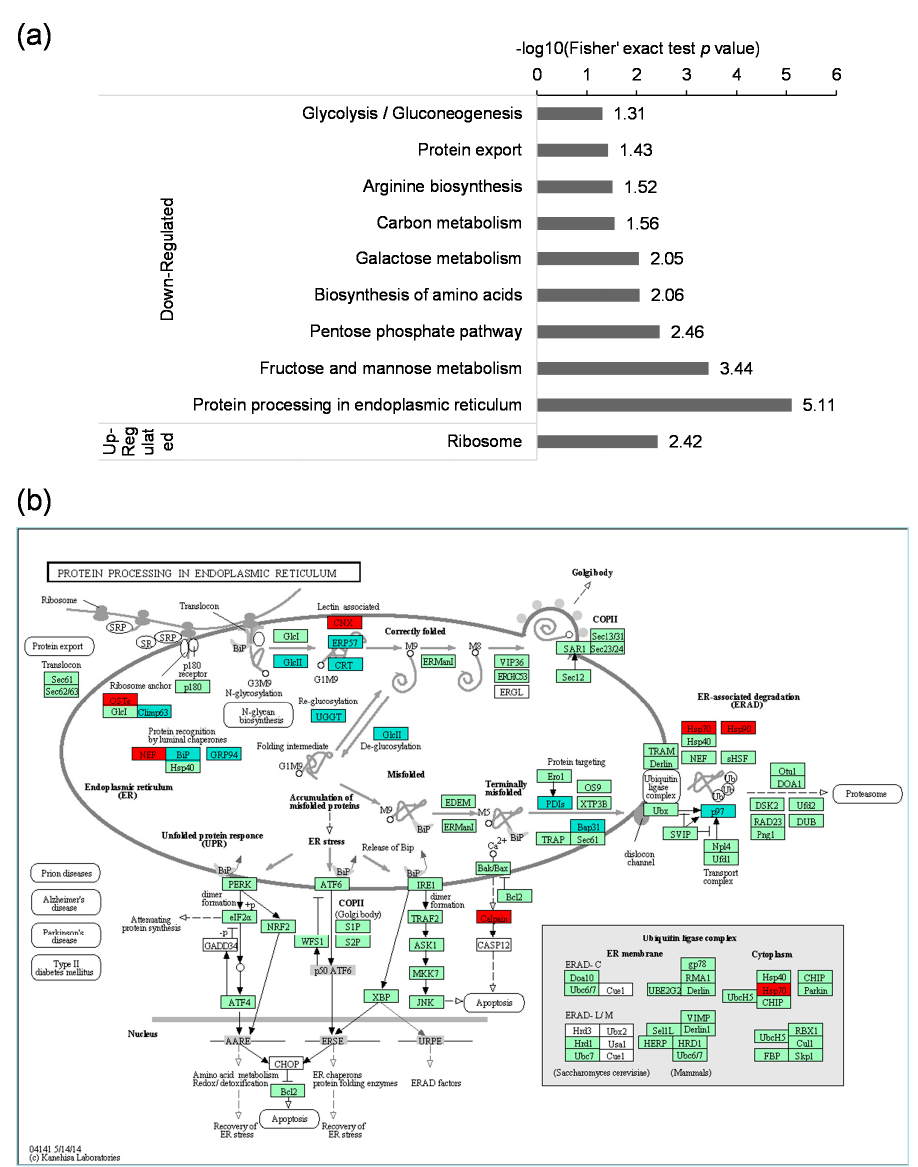
Figure 5. KEGG pathway analysis of the differentially expressed lysine acetylated proteins. ( a ) KEGG pathway-based enrichment analysis of up-regulated and down-regulated proteins; ( b ) The pathway obtained from KEGG pathway enrichment analysis. Changes in the lysine acetylation level of proteins in the protein processing in ER pathway in GCRV infected cells compared to mock-infected cells were indicated. The proteins in dark green are down-regulated, and the proteins in red are up-regulated. The proteins in light green are expressed at background